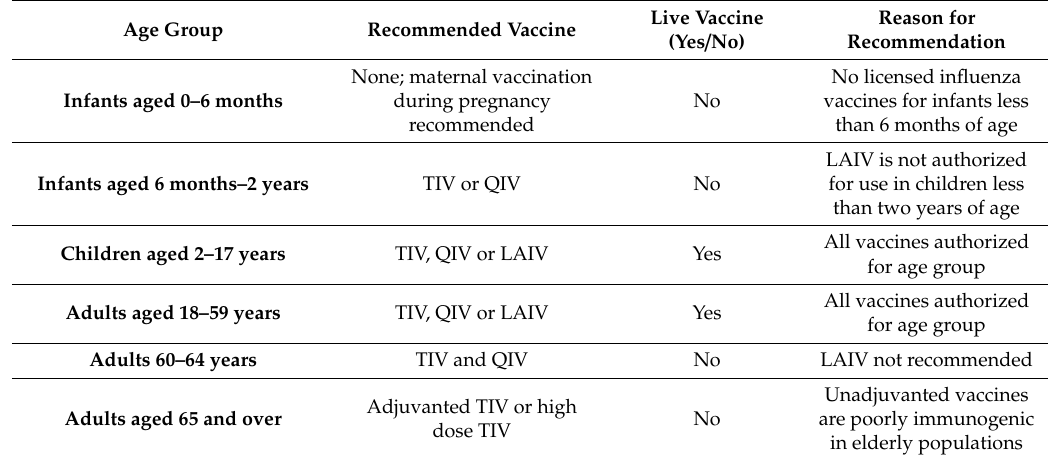
Table 1. Available influenza vaccine platforms by age group.